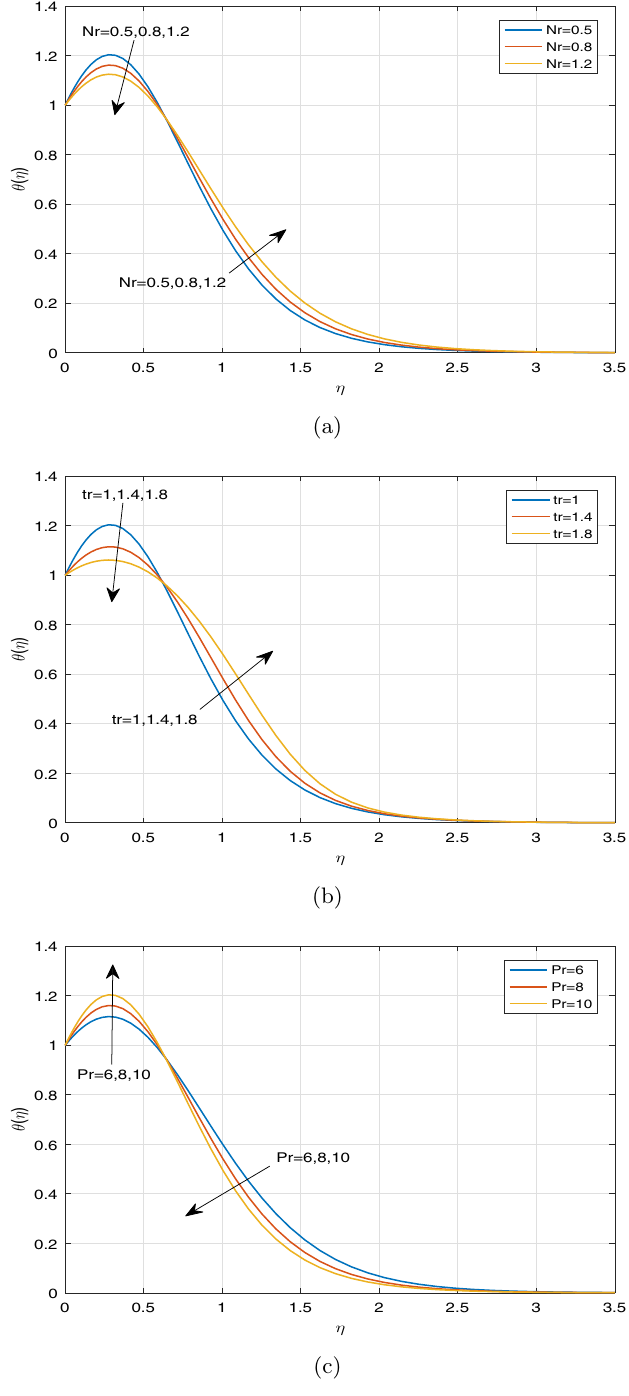
Figure 9. Temperature profiles against ( a ) Nr , ( b ) tr, ( c )